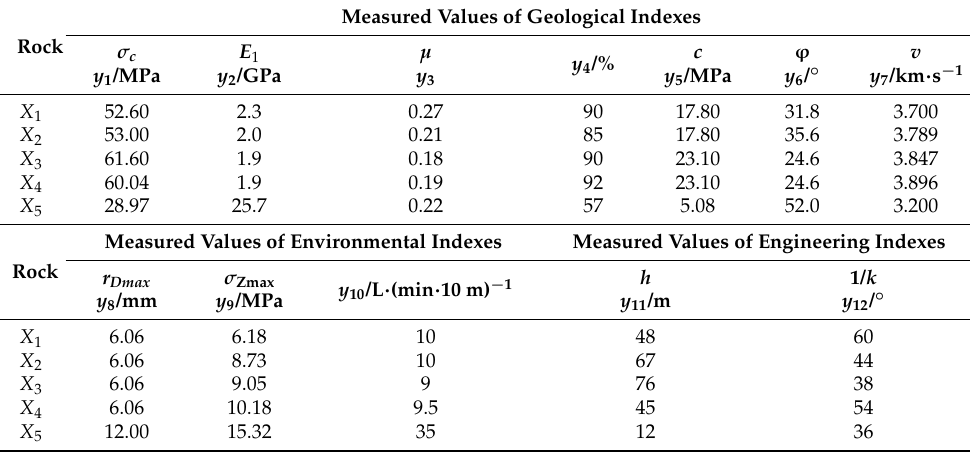
Table 2. Evaluation indexes of the slope rock mass stability.